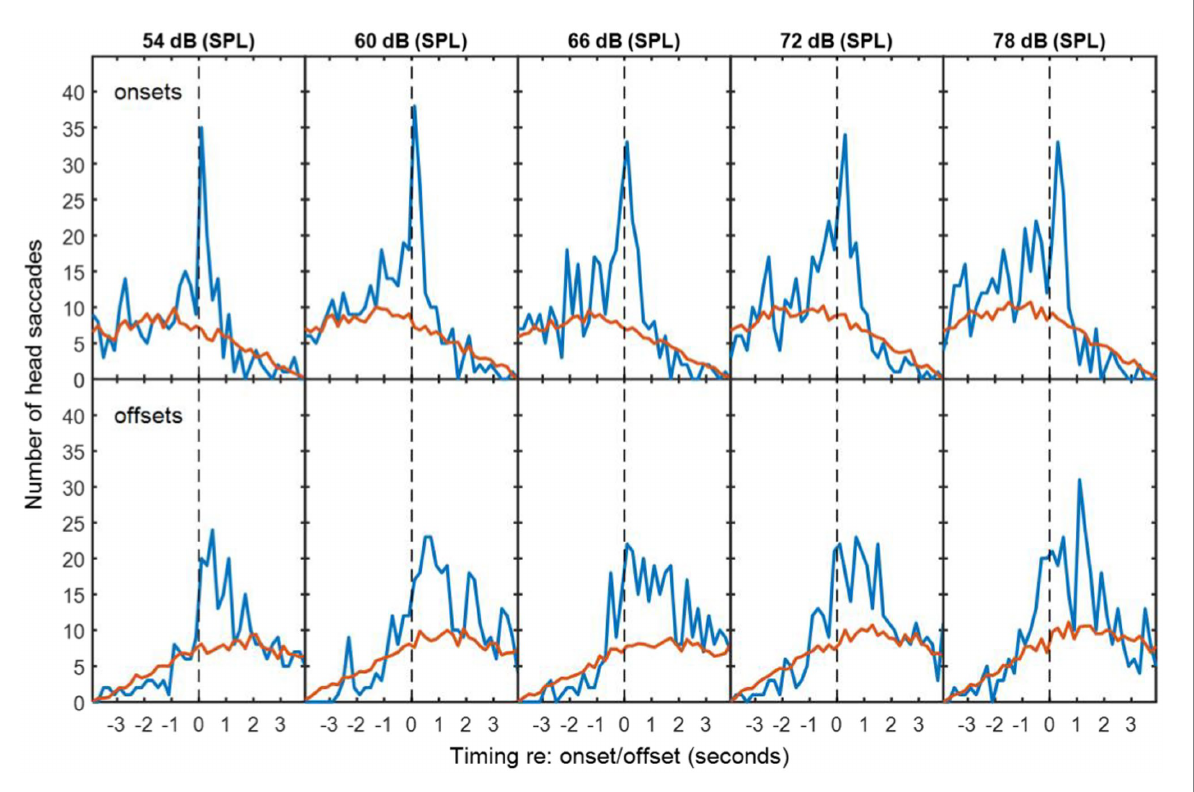
FIGURE 2 The top row of panels are histograms of number of saccades made by the participants in speech-shaped noise as a function of the time differences between these saccades and corresponding VAD onsets for the other two participants. Blue lines are for matched VAD and HM data. Red lines are for mismatched VAD and HM data, scaled to compensate for the number of different possible mismatches. Successive panels are for speech-shaped background noise at increasing sound levels. The bottom rows are similar histograms for the VAD offsets. The dashed vertical lines divide responses that preceded the VAD offset or onset from those that followed